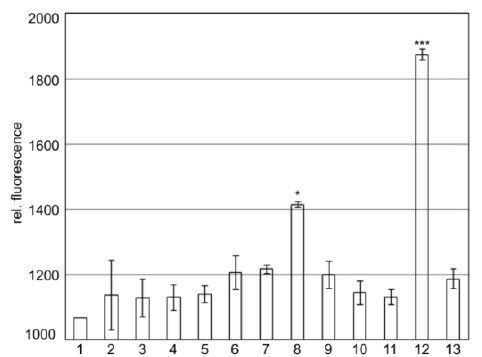
Figure 2. Bimolecular fluorescence complementation assays with different EIICB Glc derivatives and